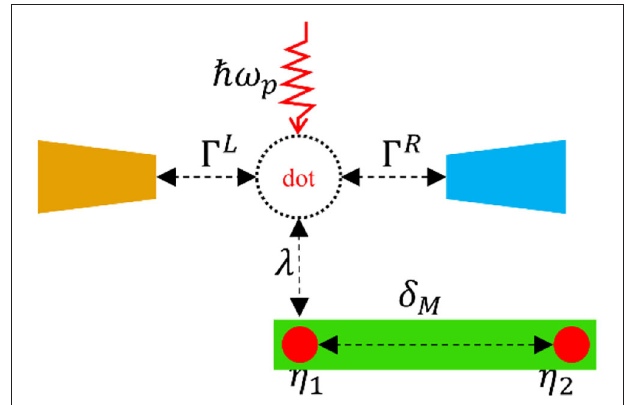
FIGURE 1 | Schematic plot of the scheme composing a quantum dot connected to the left and right leads at different temperatures of T L and T R , respectively. The dot is shelled by a microwave field with frequency ω p and intensity 1 d , and is side-coupled to a topological superconductor nanowire hosting a pair of MZMs (red circles). Here we consider that only one mode of the MZMs denoted by the operator of is coupled to the dot with strength λ . The hybridization amplitude between the MZMs is δ M